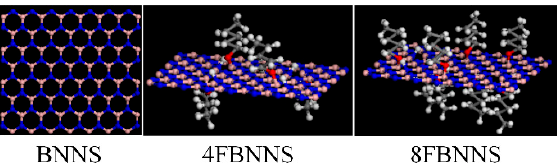
Figure 2. Molecular models for boron nitride sheets (BNNS) with different functionalization density. FBNNS: Functionalized boron nitride sheets.